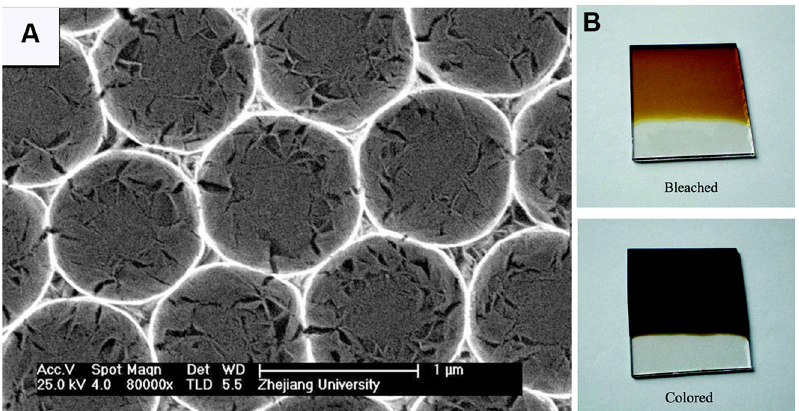
Figure 13: Characterization of Co 3 O 4 -based electrochromic fi